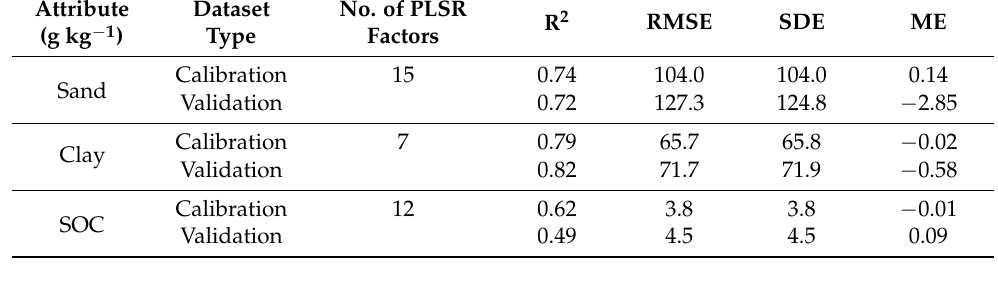
Figure 8. Illustration of distribution of SOC content using stacked histogram with two categorical variables (calibration data and validation data).